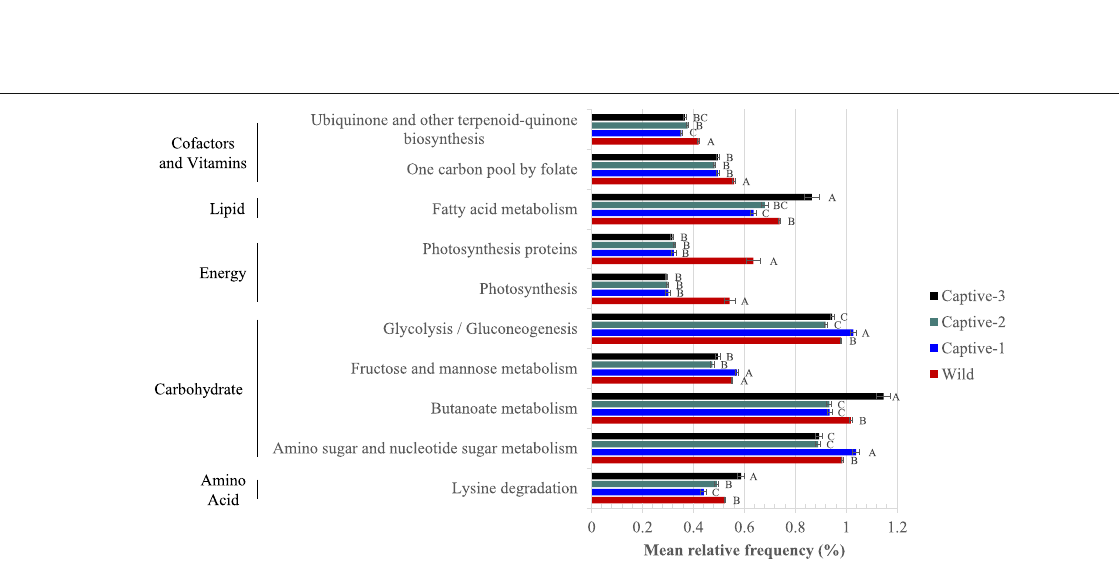
Fig. 4 Predicted microbiota function by sampling period. Only pathways with a frequency of at least 0.5% are